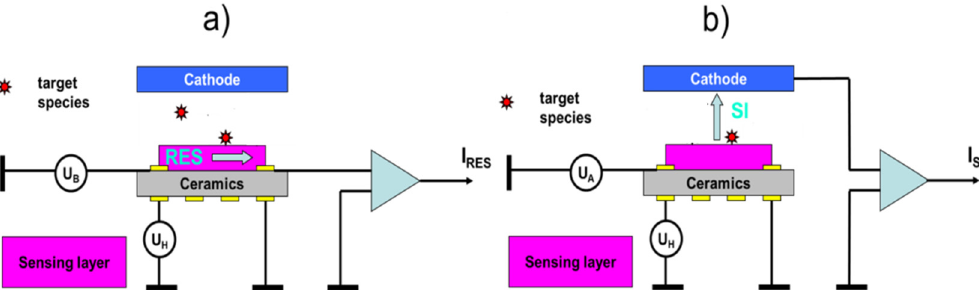
Figure 14. ( a ) MOX gas sensor operated in the conventional resistive (RES) and ( b ) in the innovative surface ionization (SI) readout mode. In the RES mode, gas adsorption is monitored via changes in the in-plane resistivity of the MOX sensing layers. The cathode layer is not normally present, but may